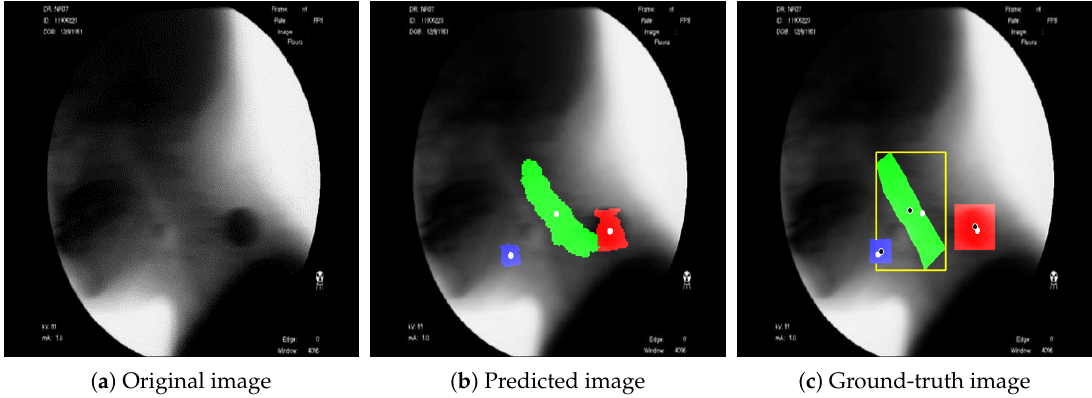
Figure 3. Segmentation results using the proposed method. ( a ) Original image; ( b ) segmentation results for the hyoid bone (blue), cervical spine (green), and coin (red). The average value of the coordinates of the detected pixels is indicated as a white spot. ( c ) Ground truth for the hyoid bone (blue), cervical spine (green: segmentation, yellow: detection), and coin (red). The average value of the coordinates of the detected pixels is indicated as a white spot, and the average value of the coordinates of the labeled pixels is indicated as a black